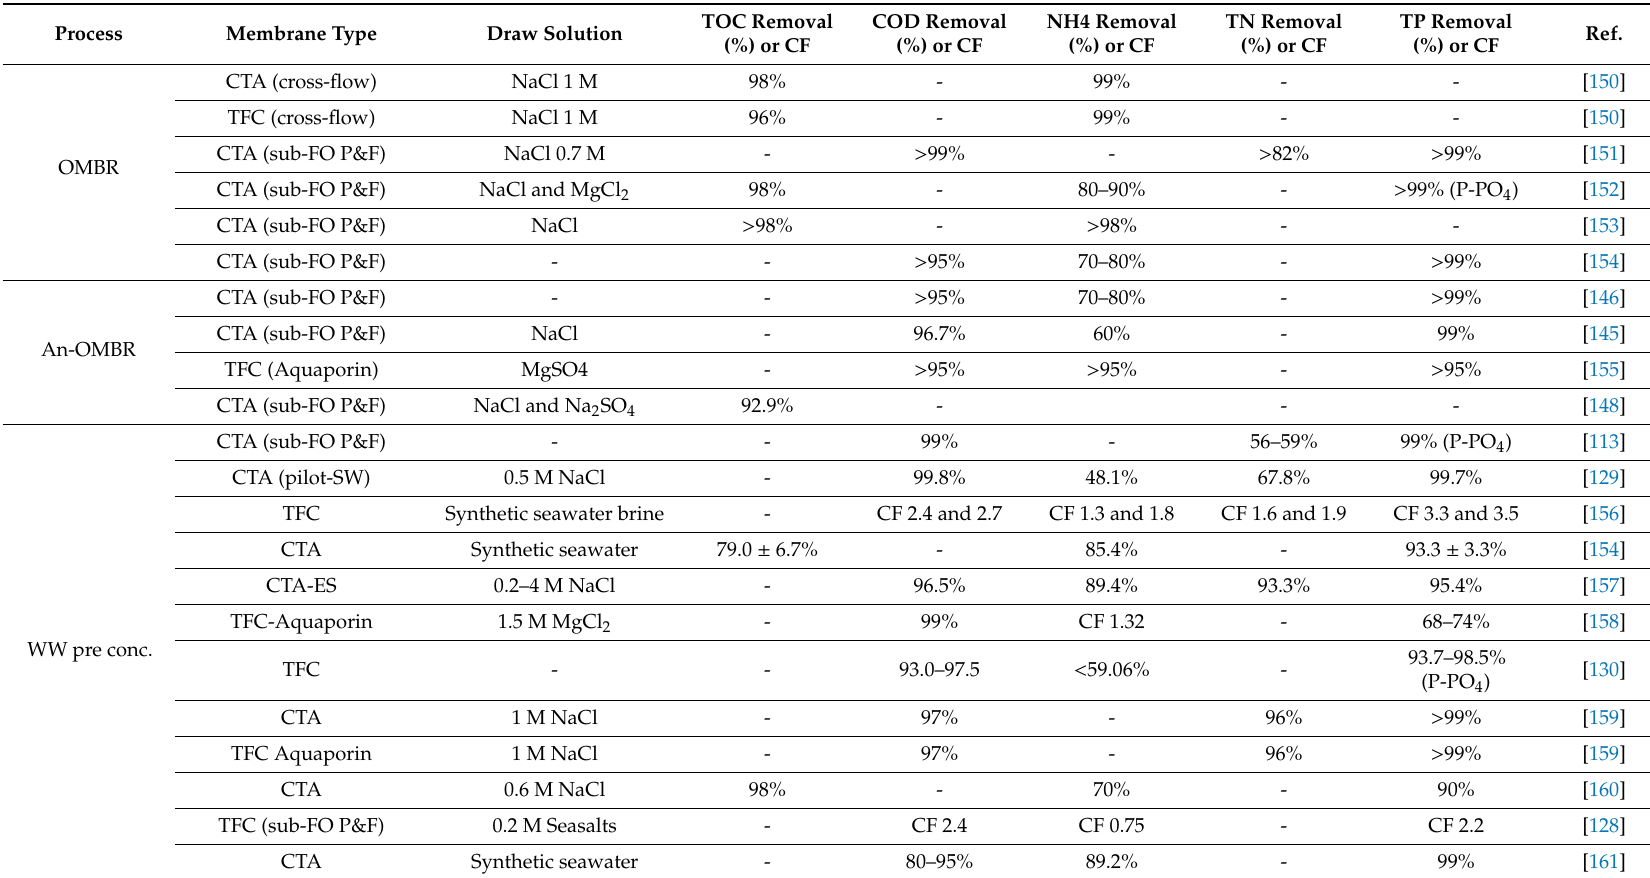
Table 5. Overview of FO integration in WW processes and e ffi ciency in rejection or concentration of nutrients. TOC, COD, NH4, TN and TP expressed in % removal or concentration factor (CF). (sub-FO: submerged forward osmosis, P&F: Plate and frame